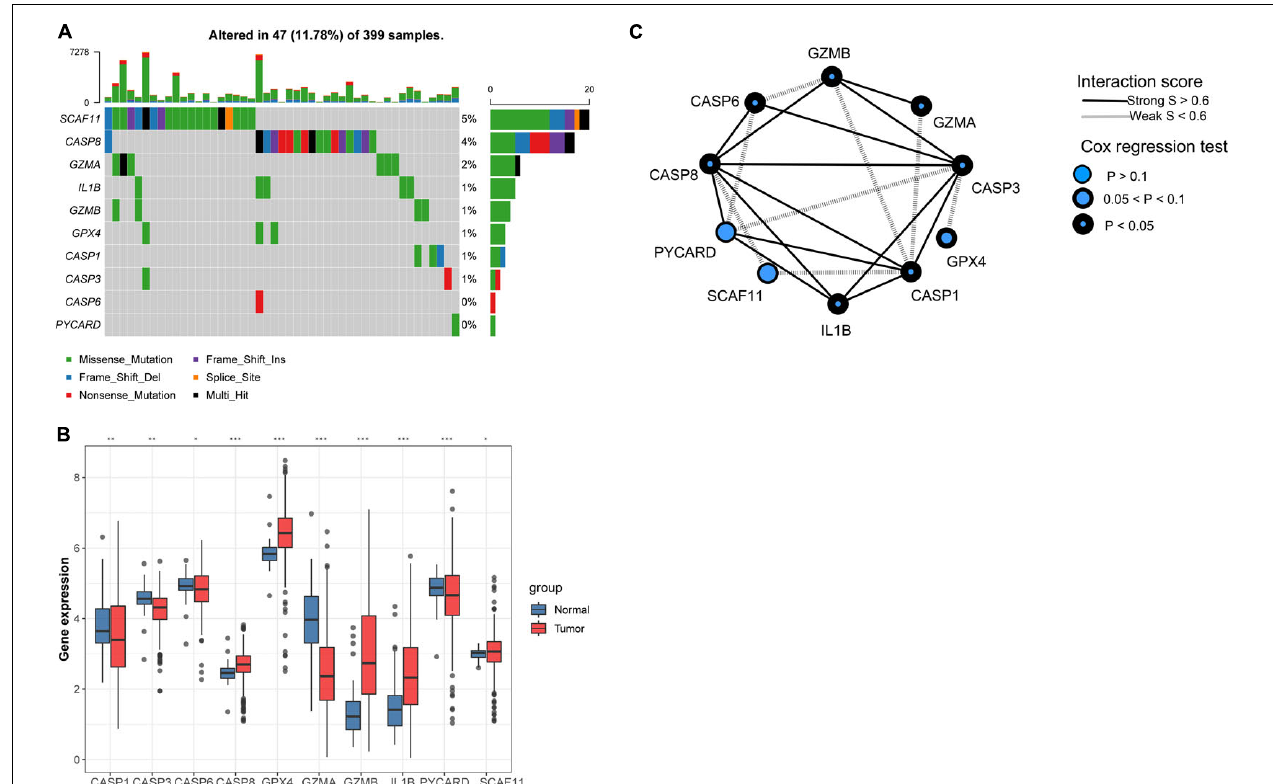
FIGURE 2 | Expressions of 10 pyroptosis-related genes in colon cancer and normal tissues. (A) Mutation frequency of 10 pyroptosis-related genes in 399 colon cancer samples from The Cancer Genome Atlas—Colon Adenocarcinoma (TCGA-COAD) cohort. (B) Differences in the mRNA expression values of the 10 pyroptosis-related genes between the normal and colon cancer samples in TCGA-COAD cohort. Asterisks represent the statistical p -value ( ns p > 0.05; * p < 0.05; ** p < 0.01; *** p < 0.001). (C) Interaction of proteins in the 10 pyroptosis-related genes. Lines connecting the pyroptosis-related genes represent their interaction with each other. The size of each circle represents the prognostic effect of each regulator and scaled by the p